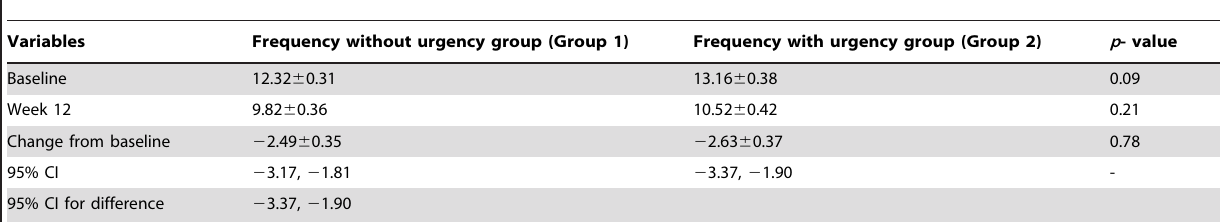
Table 2. Non-inferior analysis of solifenacin in patients with urinary frequency with or without urgency.